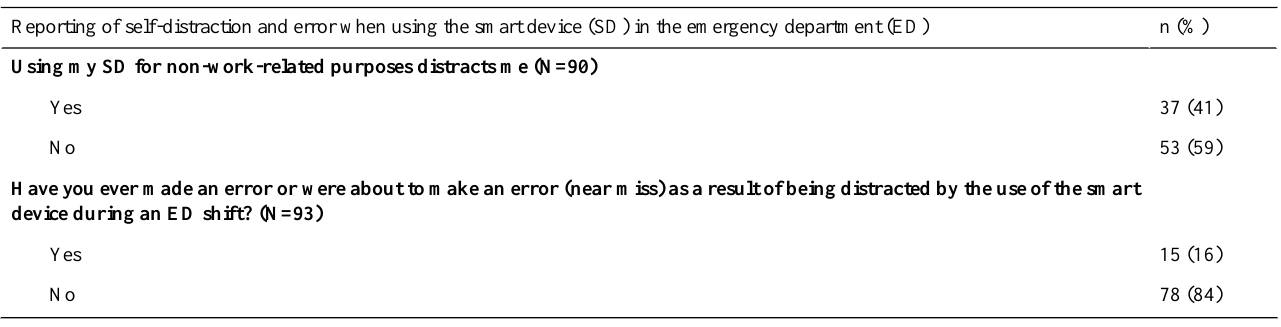
Table 6. Reporting of self-distraction and error when using the smart device in the emergency